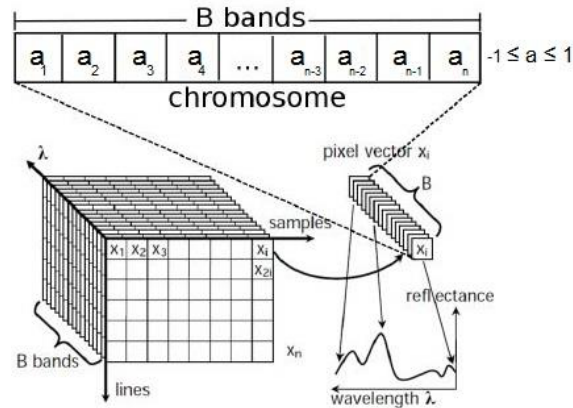
Figure 1: Chromosome representation, adapted from (Tarabalka, 2010).